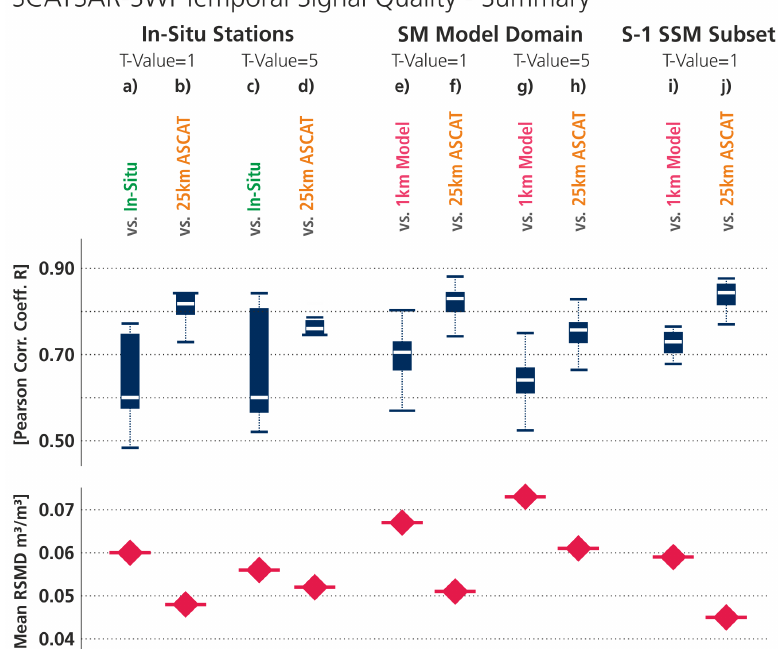
Figure 6. Compilation of statistics on Pearson R-values and average RMSD from the time series analyses between SCATSAR-SWI and SM references (Model SM, ASCAT SSM, In Situ SM) over in situ stations ( a – d ), Umbria SM model ( e – h ), and Umbria SM model subset area with good S-1 SSM performance (“S-1 SSM Subset”, ( i , j